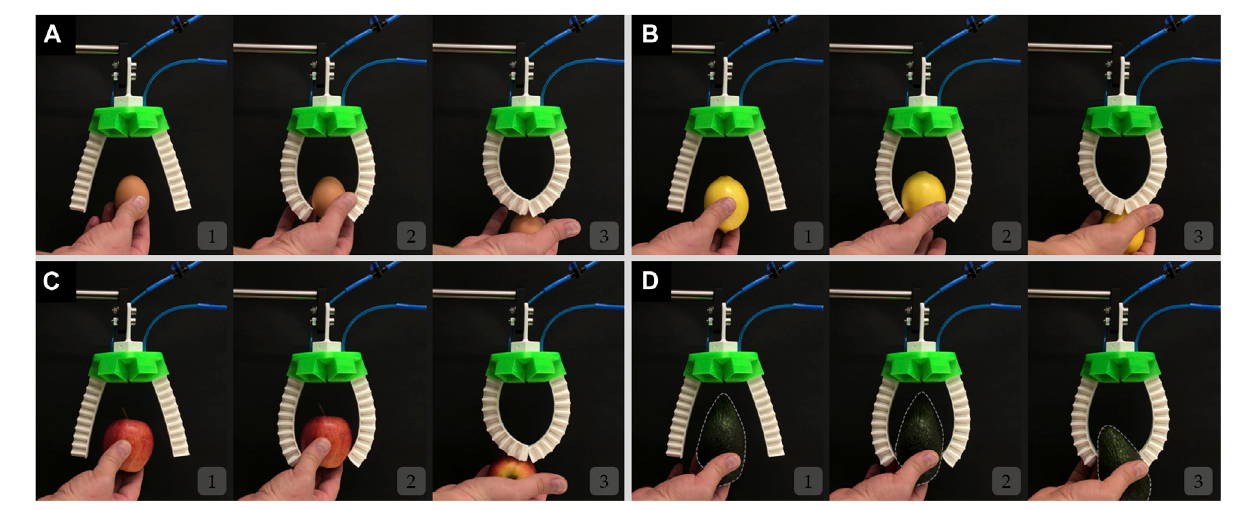
FIGURE7| Thesoftmodulargripperinatwo- fi ngercon fi gurationwithoutthemechanicalmetamaterialattemptstobutfailstograsp (A) anegg, (B) alemon, (C) an apple, and (D) an avocado.